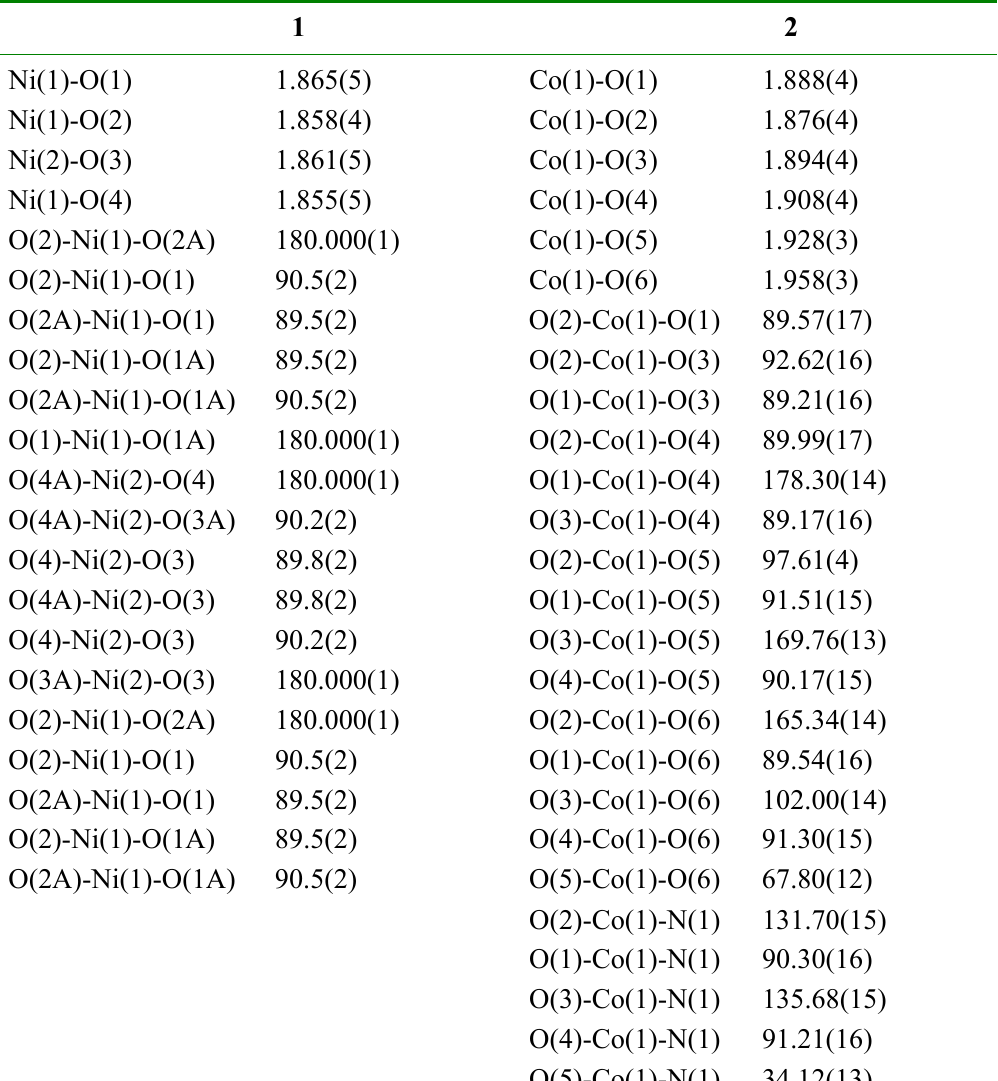
Table 2. Selected bond (Å) distances and angles ( o )